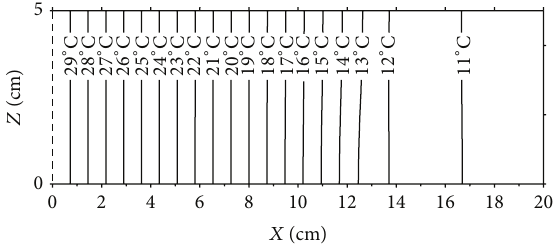
Figure 9: Temperature distributions after 135 days.